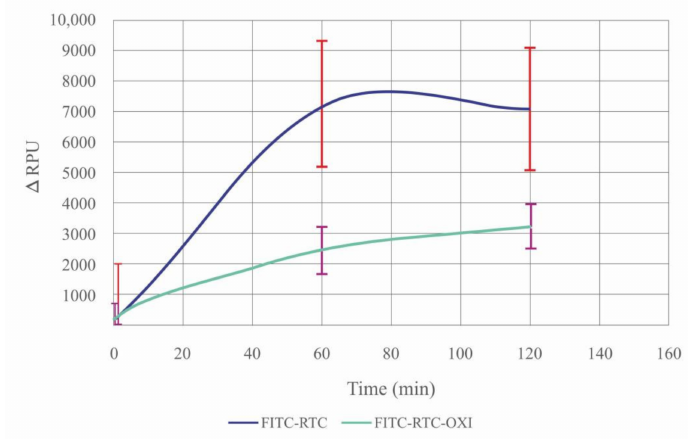
Figure 6. Relative changes in the fluorescence intensity upon addition of FITC-Col (blue) or oxidized FITC-Col I-OXI (green) to a solution of collagenase CH as substrates for proteolytic digestion at times of 0, 60 and 120 min at 37 ◦ C. Fluorescence intensity is presented as RPU subtracting the fluorescent signal of samples with collagenase and those without collagenase (negative control), directly characterizing the proteolytic de-quenching.